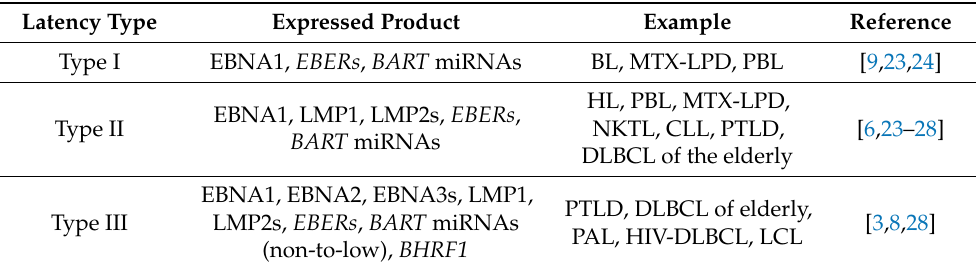
Table 1. Expression patterns of EBV-encoded products in different latency programs with references to selected cancers. Some entities may represent two types of